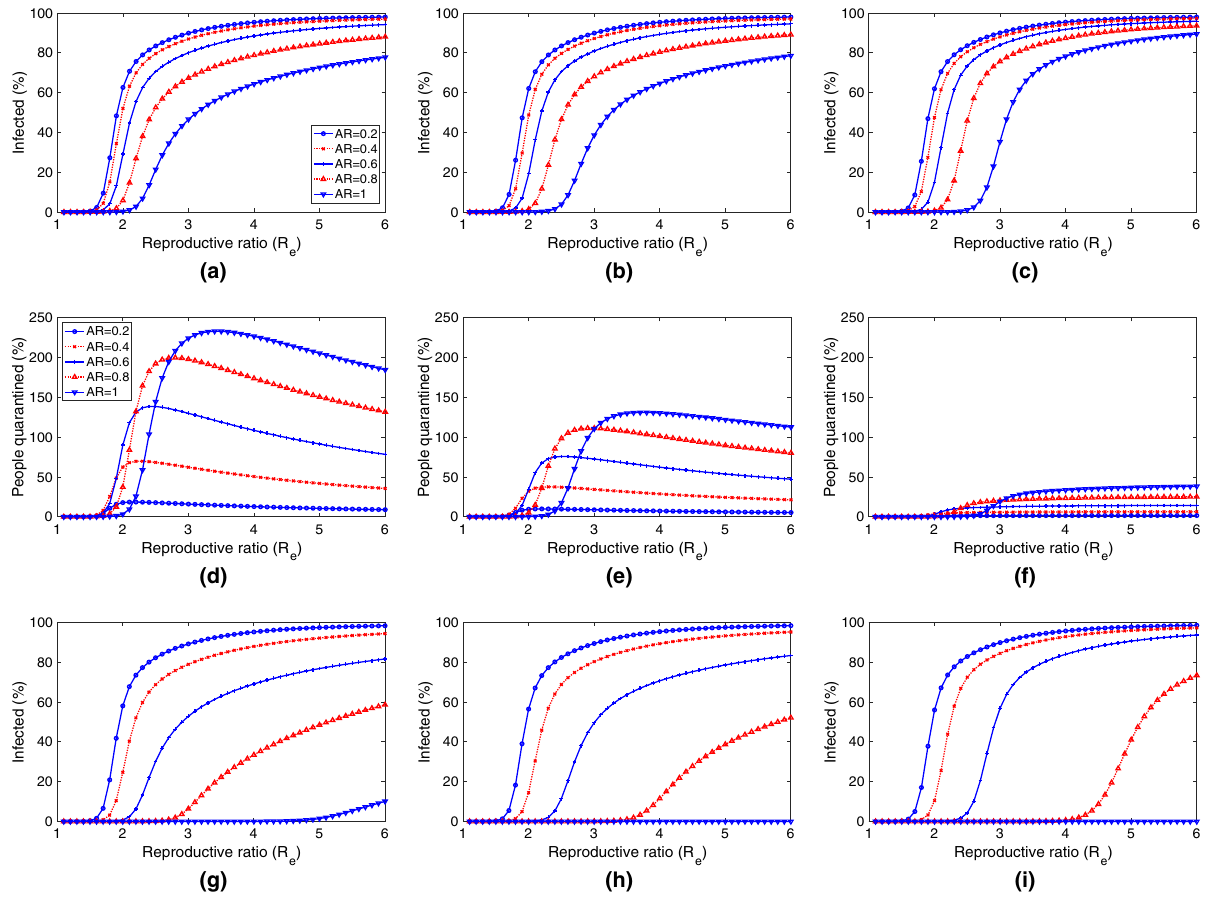
Figure 9. Future digital contact tracing efficiency depending on the reproductive ratio R e and for several adoption ratios, showing the percentage of the population infected and quarantined. Figures ( a ) and ( d ) show the results for a digital contact tracing approach with parameters similar to the ones deployed for the COVID- 19. Figures ( b ) and ( e ) show the results when the accuracy is increased ( TPR is increased (0.7 to 0.9), and FPR is reduced (0.4 to 0.2). Figures ( c ) and ( f ) show a full accuracy scenario with TPR = 1 ; The last row, figures ( g ), ( h ) and ( i ), show a centralised approach ( TT = 1 , TC = 1 ) with the same accuracy than figures ( a ), ( b ) and ( c